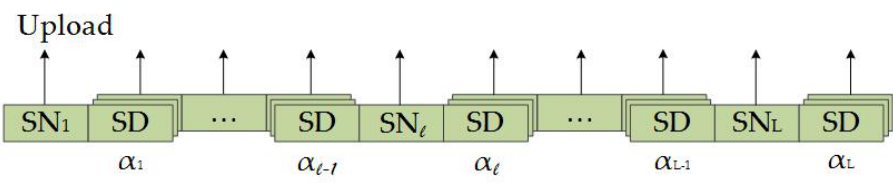
Figure 8. The status of the reordering buffer after the transmission in Category